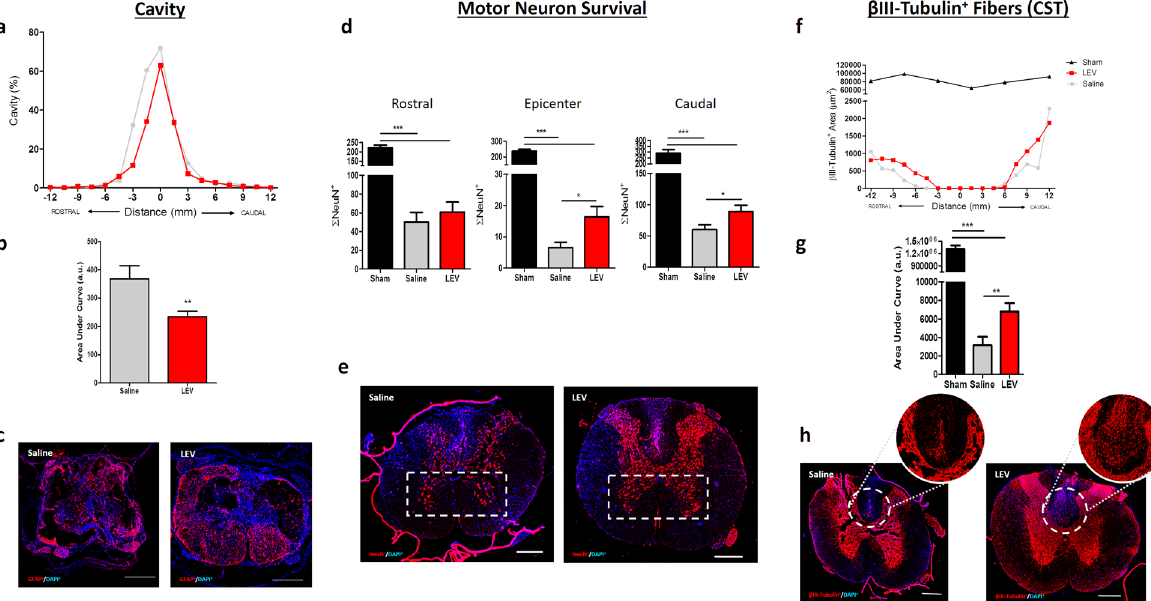
Fig. 4 The effect of LEV on cavity size, motor neurons survival, and CST axons preservation. a Mean cavity size distribution along the rostral-caudal axis of LEV and saline-treated animals, b Cavity quanti fi cation revealed that LEV treatment signi fi cantly reduced cavity size after SCI. Sham animals did not presented any cavitation. c GFAP + staining was used to demarcate the cavity of both LEV and saline-treated animals. d The sum of motor neurons was determined at rostral, caudal and epicenter regions. LEV treatment was able to signi fi cantly protect motor neurons at epicenter and caudal regions. e Representative confocal photomicrographs of NeuN + cells. f Rostral-caudal distribution of positive neuronal fi ber staining at CST. g Quanti fi cation of β III-Tubulin + staining at CST revealed signi fi cant neuronal fi ber preservation on LEV-treated rats. h Representative confocal photomicrographs of β III-Tubulin + staining. Values shown as mean ± SEM. * p < 0.05; ** p < 0.01; *** p < 0.001. Scale bar = 400 µm. Sham n = 3; Saline n = 8; LEV n =